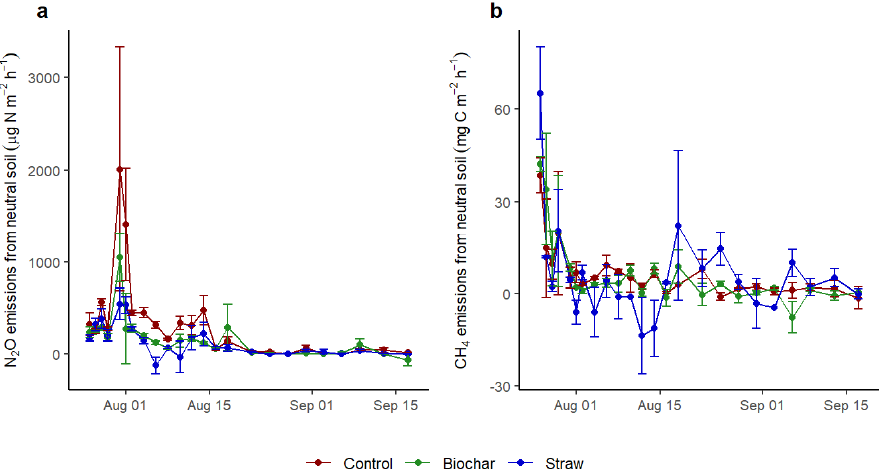
Figure 3. Temporal variations (July 2020–September 2020) of the ( a ) N 2 O and ( b ) CH 4 emissions from neutral soil after addition of maize straw and corn biochar in an outdoor packed soil column. The perpendicular lines indicate the standard error of the mean (n = 3).